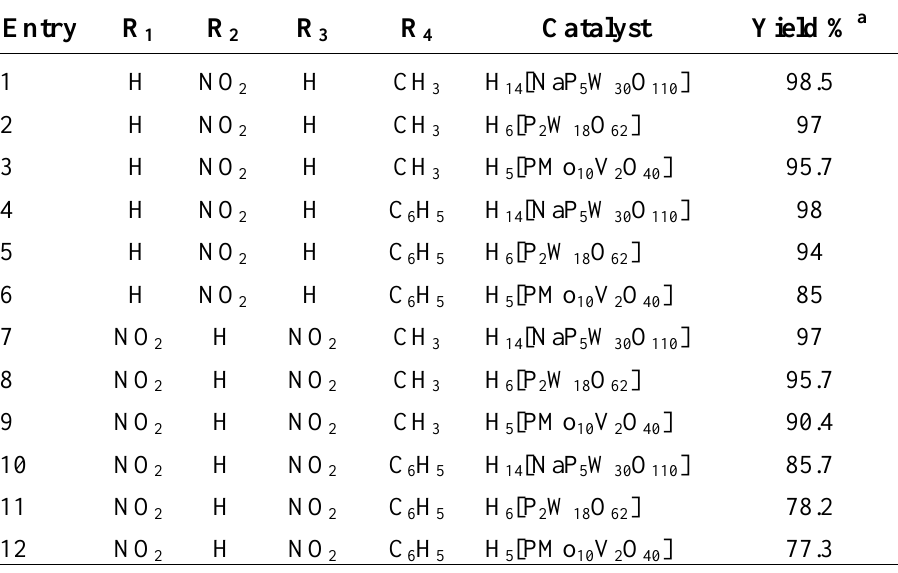
Table 3. Synthesis of benzimidazole derivatives using various heteropolyacids under refluxing